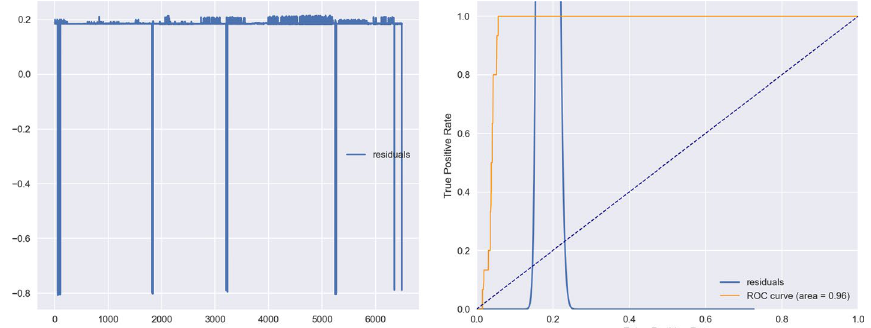
Fig. 4 Results of applying XGBoost to D20 D21 fused data increase AUC dramatically. Left: residual + sequence with original timed order. Right: ROC curve and residual distribution